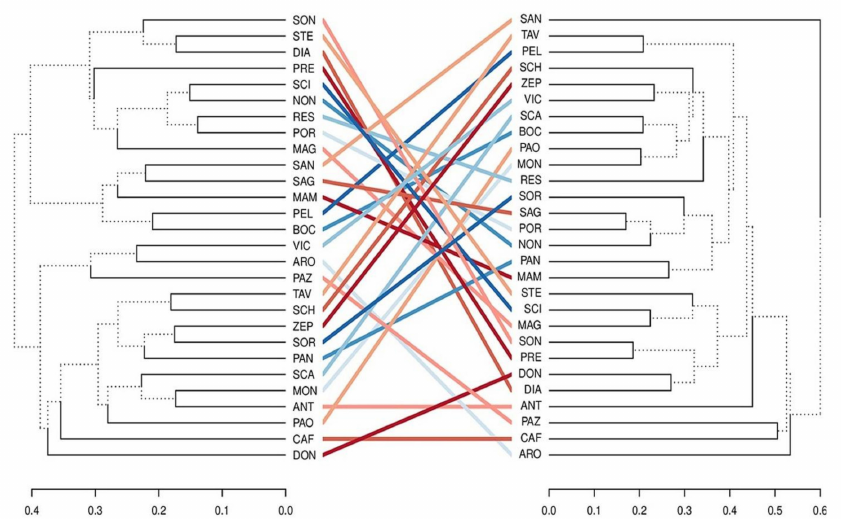
Figure 4. A comparison of the hierarchical clustering of the apricot varieties using morphological (left tree) or SSR marker (right tree) data. Clustering was performed with the UPGMA algorithm for both dendrograms. To ease the comparison, coloured lines connect identical names. The different line types in the dendrograms highlight distinct edges in a tree (compared to the other